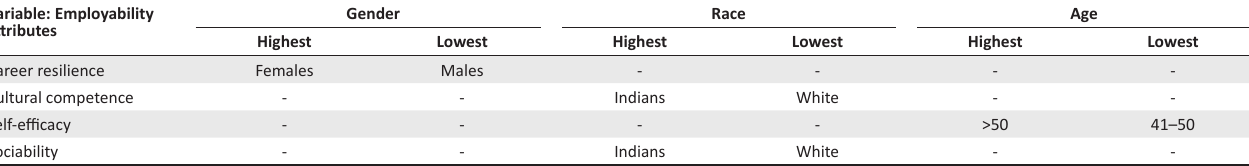
TABLE 5: Differences between the gender, race and age groups in terms of employability variables. Variable: Employability